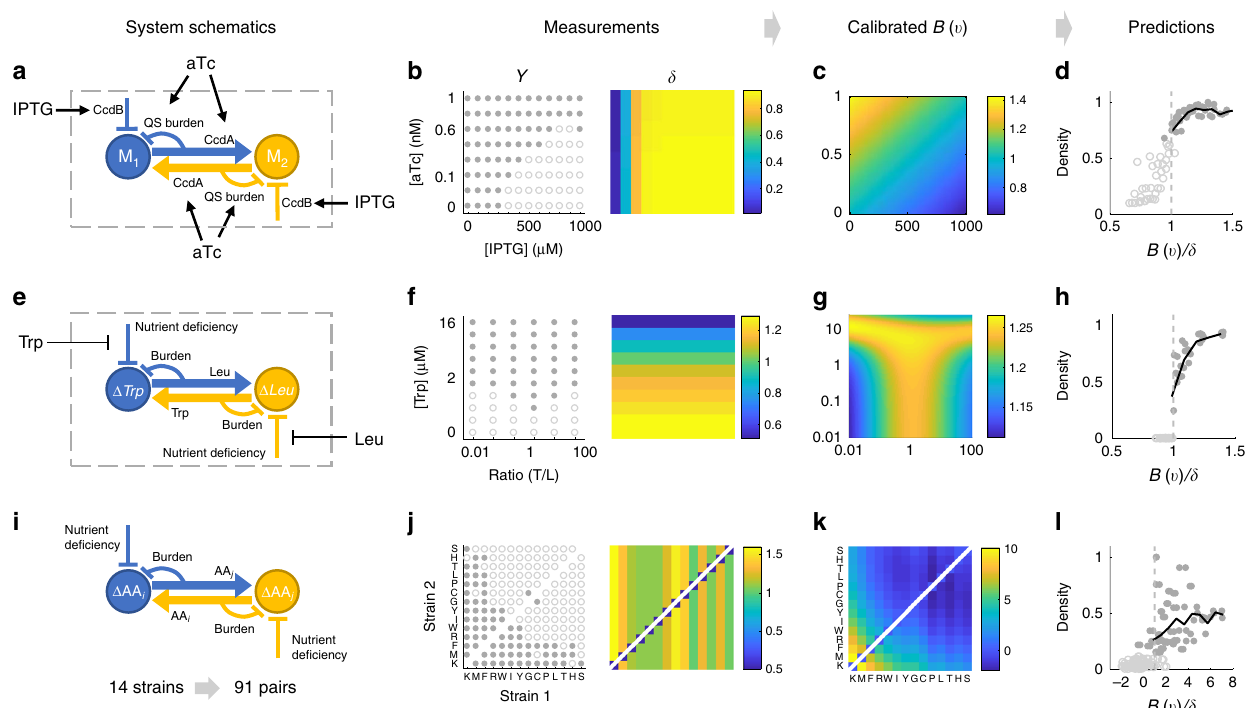
Fig. 3 Application of the framework to experimental systems (see Supplementary Movies 2 – 4). a The QS-based mutualism system. IPTG modulates stress and aTc induces QS-mediated mutualistic interaction. b Measurements of coexistence and collapse and corresponding δ values. Coexistence and collapse are measured by coculturing the two strains starting from the same initial densities. δ is measured by OD of M 2 monoculture after 32 h of culturing. c Empirical calibration of B ( v ). B ( v ) reveals how [IPTG] and [aTc] together modulate the effectiveness of the interaction. d B ( v )/ δ is predictive of coexistence versus collapse and total fi nal density. The x -axis range of [0.5 – 1.5] is used to highlight the transition (this also applies to other prediction plots). The trend continues to hold beyond this range. The y- axis represents normalized fi nal cell density. e The pairwise yeast auxotroph system. The growth of both auxotrophs are suppressed in monocultures. With increasing Trp and Leu supplemented to the co-culture, the growth suppression can